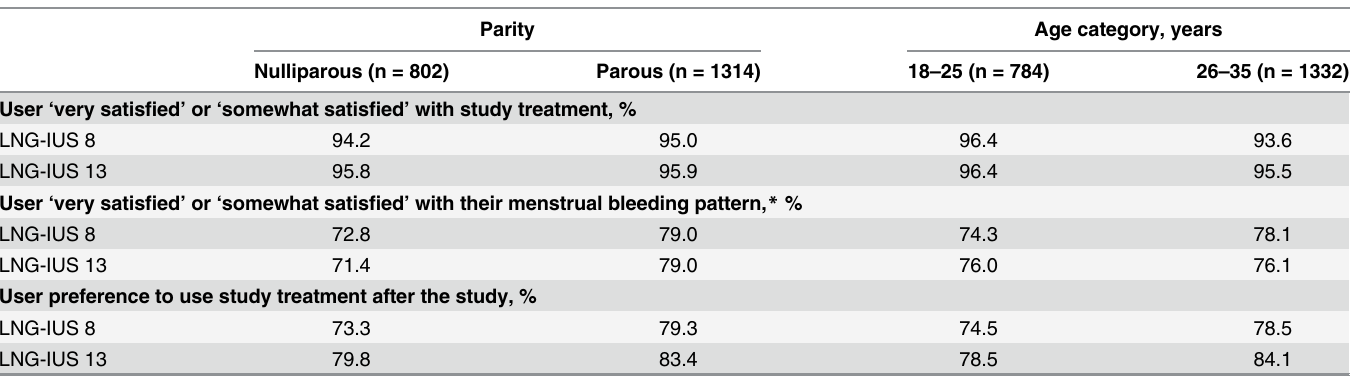
Table 7. User Satisfaction According to Parity Status and